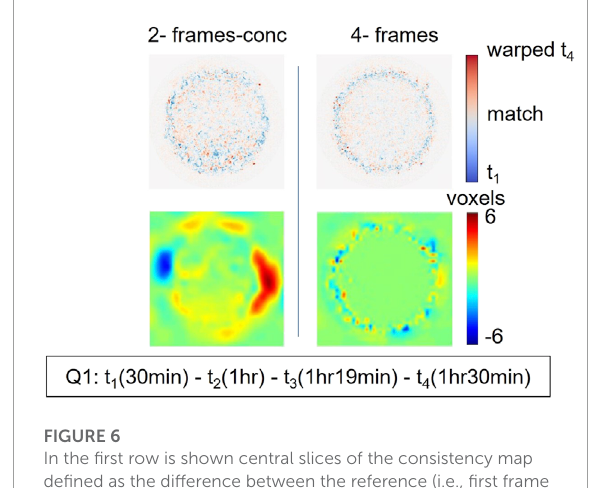
FIGURE 6 In the first row is shown central slices of the consistency map defined as the difference between the reference (i.e., first frame of the temporal sequence) and deformed volumes (i.e., deformed last frame of the temporal sequence): blue regions correspond to material of t1 does not match material in the warped t4; red regions correspond to material of the warped t4 does not match material in t1; white regions correspond to material of warped t4 that fully overlap material in t1. In the second row the magnitude of the displacement field computed using 2-frames-conc and 4-frames in the plane x-y is